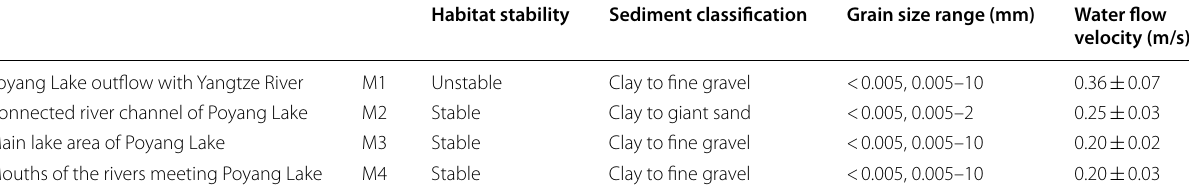
Table 1 Habitat stability, sediment composition, particle size and water flow velocity in four habitats, Poyang Lake